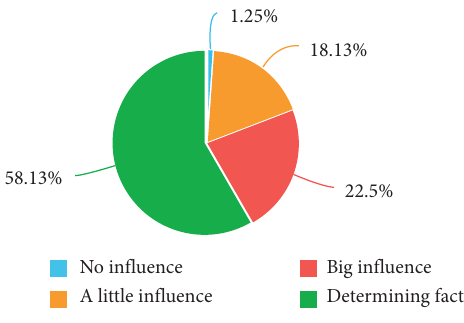
Figure 7: Effect of parking